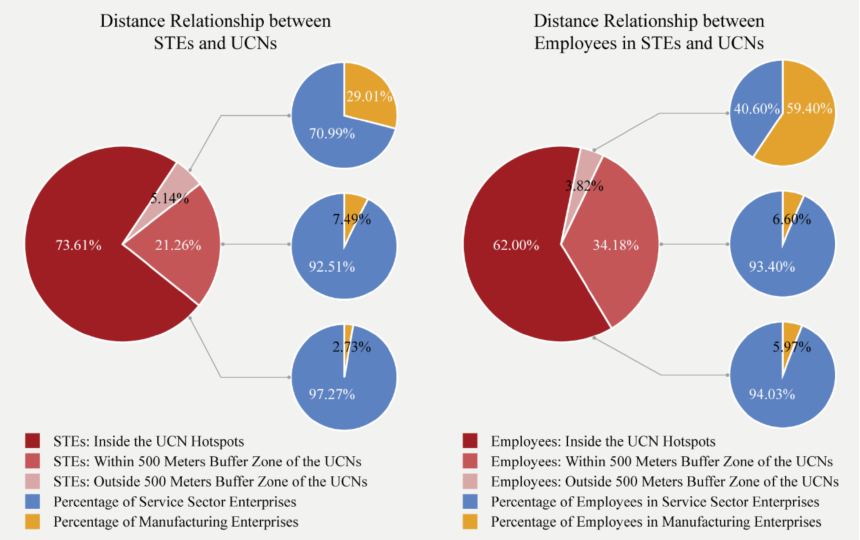
Figure 10. Distance relationship among STEs, employees in STEs, and